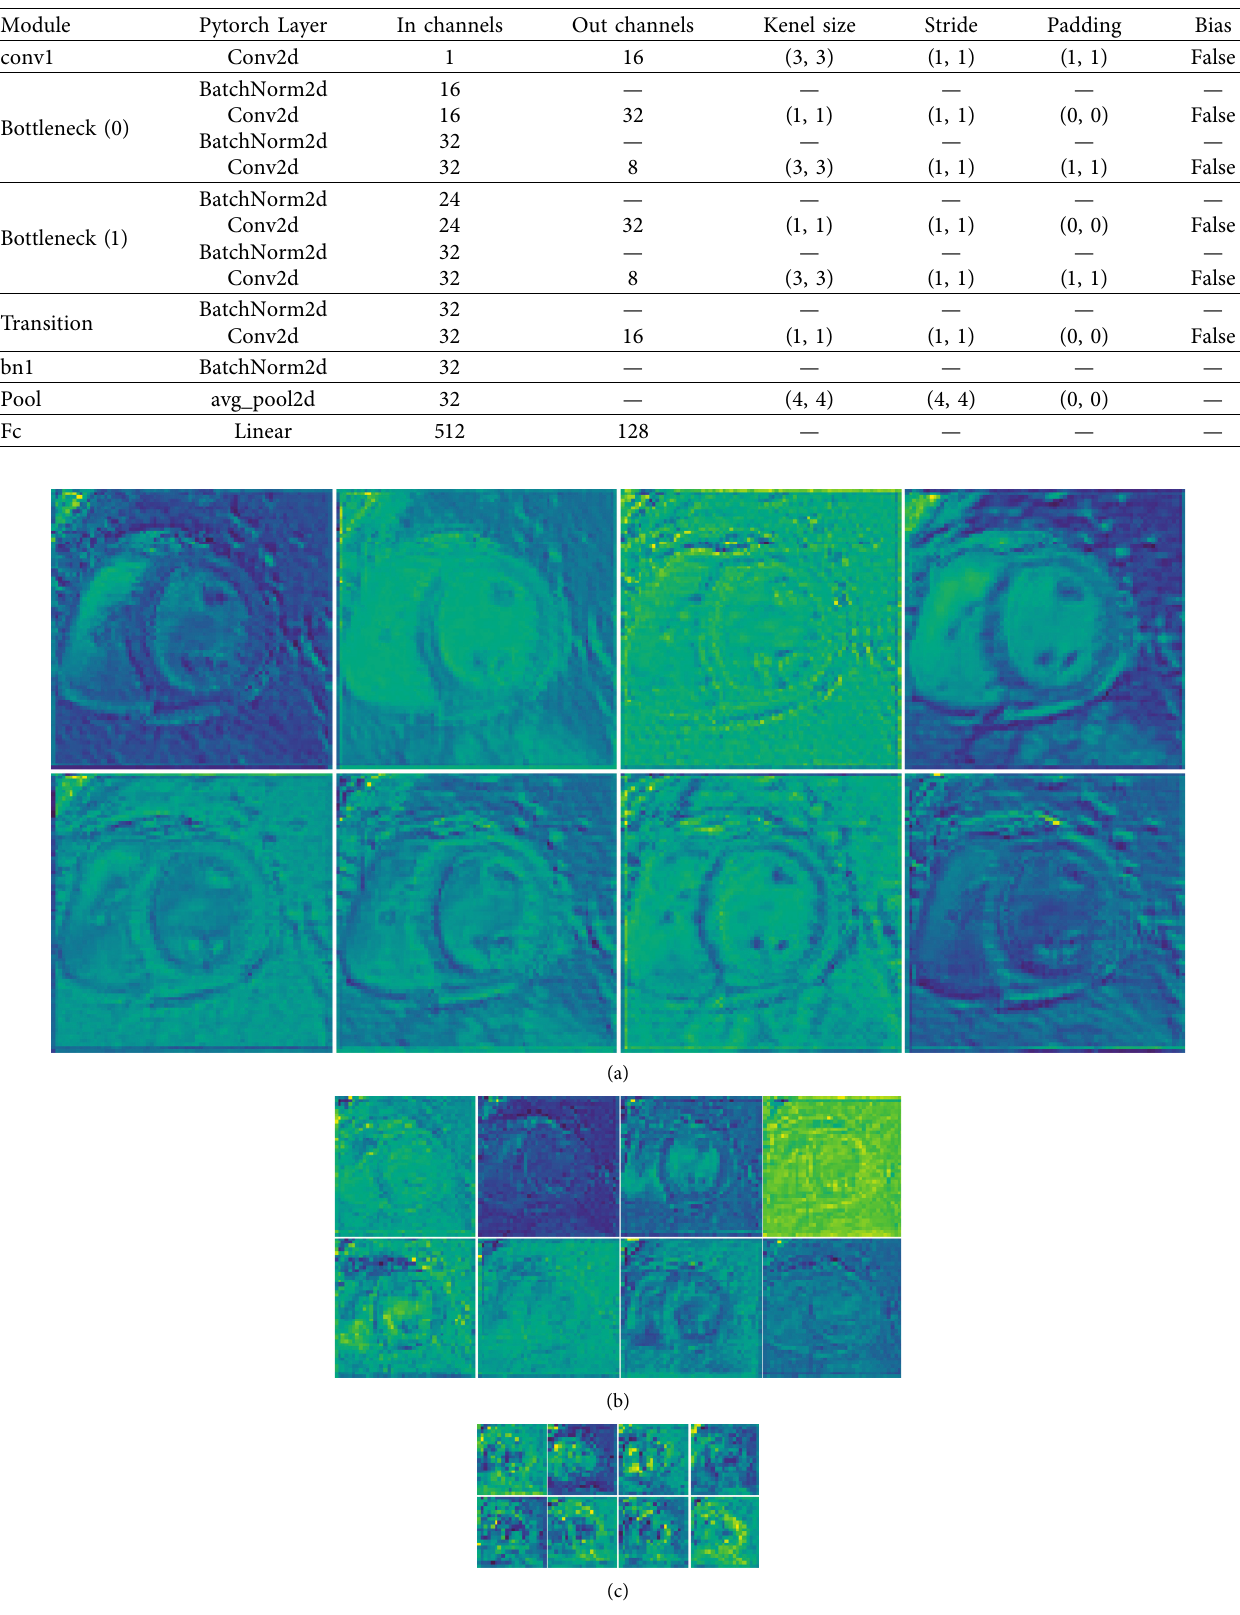
Figure 3: Feature map visualization for DenseNet. Feature maps from the first, second, and third DenseBlock are presented in (a) 8 × 80 × 80, (b) 8 × 20 × 20, and (c) 8 × 40 × 40 in which the number of filters is 8 and the receptive field becomes smaller with the layers going